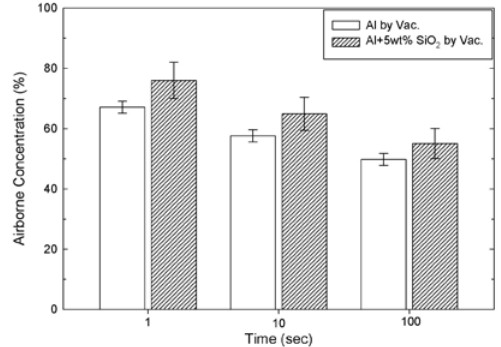
Airborne concentration of aluminum particles by vacuum dis- semination. The addition of 5 wt% silica to the aluminum demon- strated a 10-20% increase in airborne